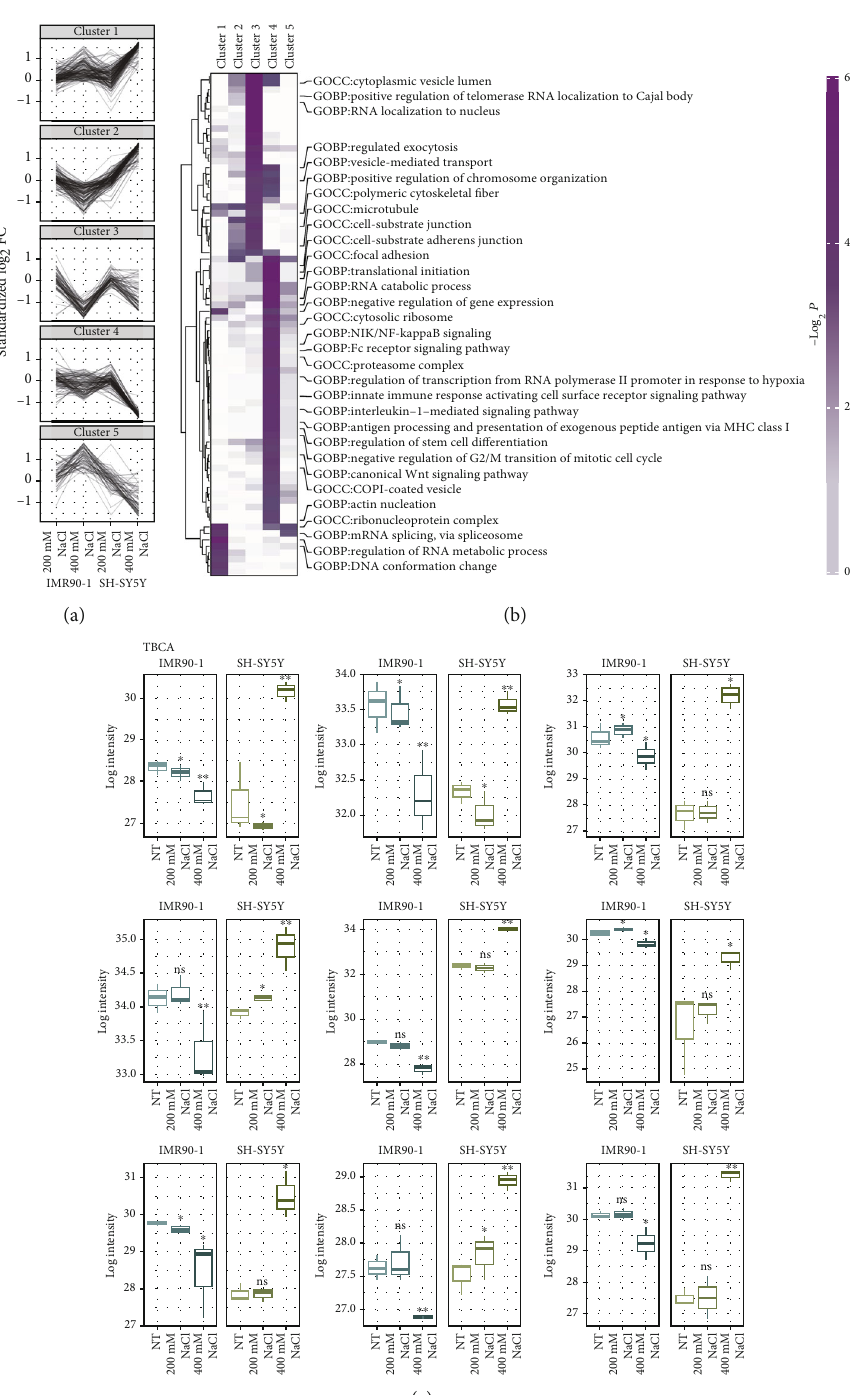
Figure 4: Clustering and functional overrepresentation analysis of di ff erential proteomic data. (a) Fuzzy c-means clustering identi fi es distinct patterns in protein levels upon NaCl treatment in hiPSCs/IMR90-1 and SH-SY5Y cells. Clustering into 5 clusters was performed to standardized changes in protein levels when compared to untreated cells ( p < 0 : 05 ). Pro fi le plots of the clusters indicate the following general states: 1 and 2, strongly increased expression in 400mM in hiPSCs/IMR90-1; 3, moderate increase expression in 400mM in hiPSCs/IMR90- 1; and 4 and 5, decreased expressions in 400mM in hiPSCs/IMR90-1. (b) Heatmap showing Gene Ontology (GO) terms which are statistically overrepresented within clusters as indicated by a high − log 10 p value. (c) Selected subtype markers across selected cluster 3 in hiPSCs/IMR90-1 and SH-SY5Y. Selected subtype markers exhibit the subtype-expected pattern (for each pairwise comparison, we used Student t -test, ∗ FDR < 0 : 05 ). Microtubule proteins, TBCA, TUBB, STMN1, TUBA1B, TUBB4B, PKBP4, DYNC1H1, MAPRE1, and DPYSL2 were signi fi cantly lower in hiPSCs/IMR90-1 under 400mM of NaCl treatment. NT: no treatment; ns: not signi fi cant compared to NT; ∗ FDR : adjusted p value less than 0.05 compared to NT; ∗∗ FDR : adjusted p value less than 0.01 compared to